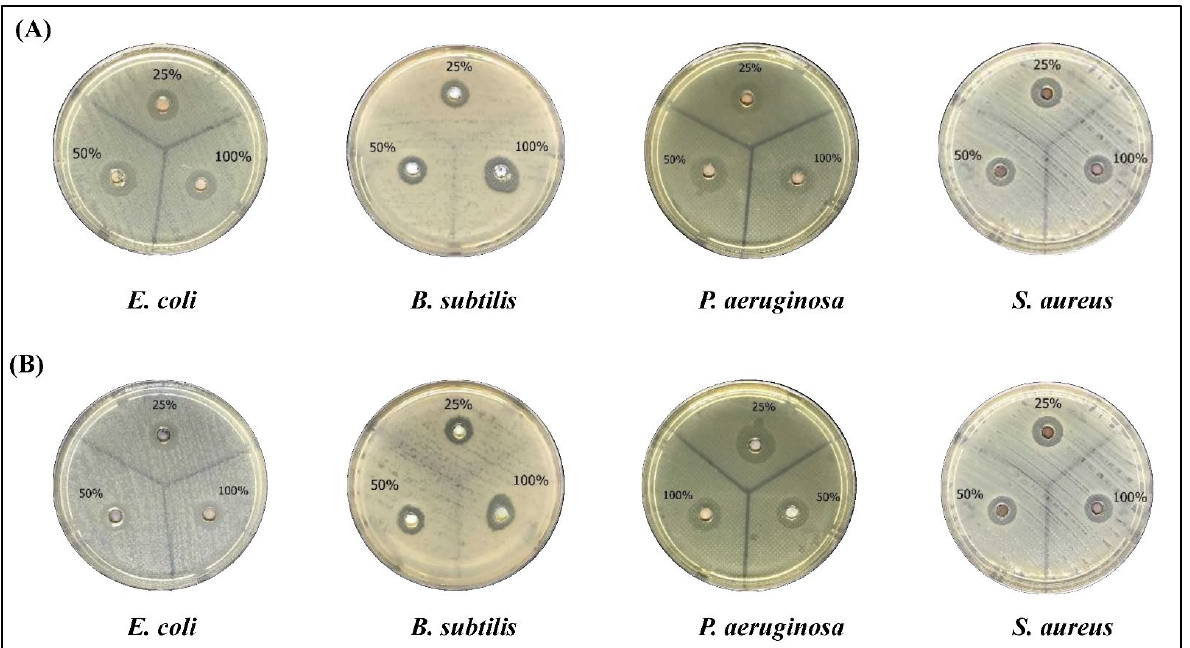
Figure 6. The antibacterial activity of AgNPs preparations from Phoenix dactylifera L leaves extracts. Different bacterial strains were grown on Mueller Hinton Agar (MHA) Plates and treated with three concentrations of AgNPs (25, 50, 100% (10 mg/mL)). ( A ) aqueous extract, ( B ) ethanolic extract. Table 4. Zone of inhibition for bacterial strains treated with AgNPs of the Palm leaves aqueous extract. Species